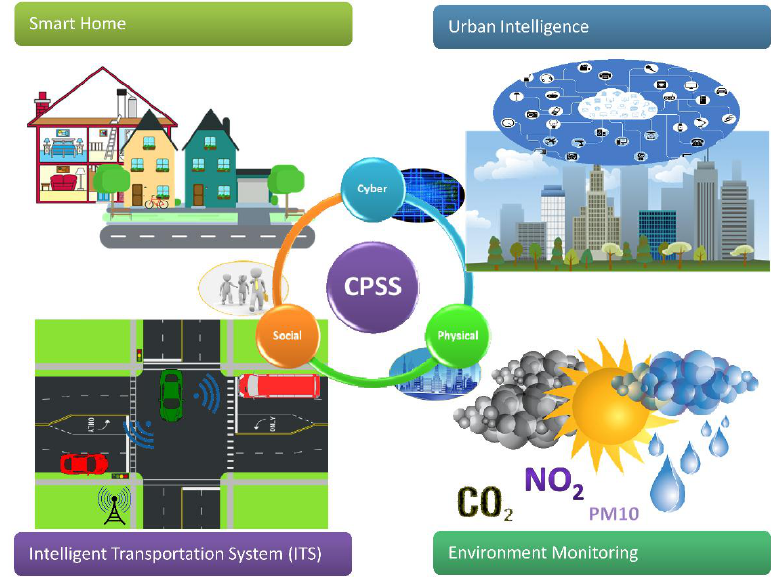
Figure 7. CPSS Application Domains.